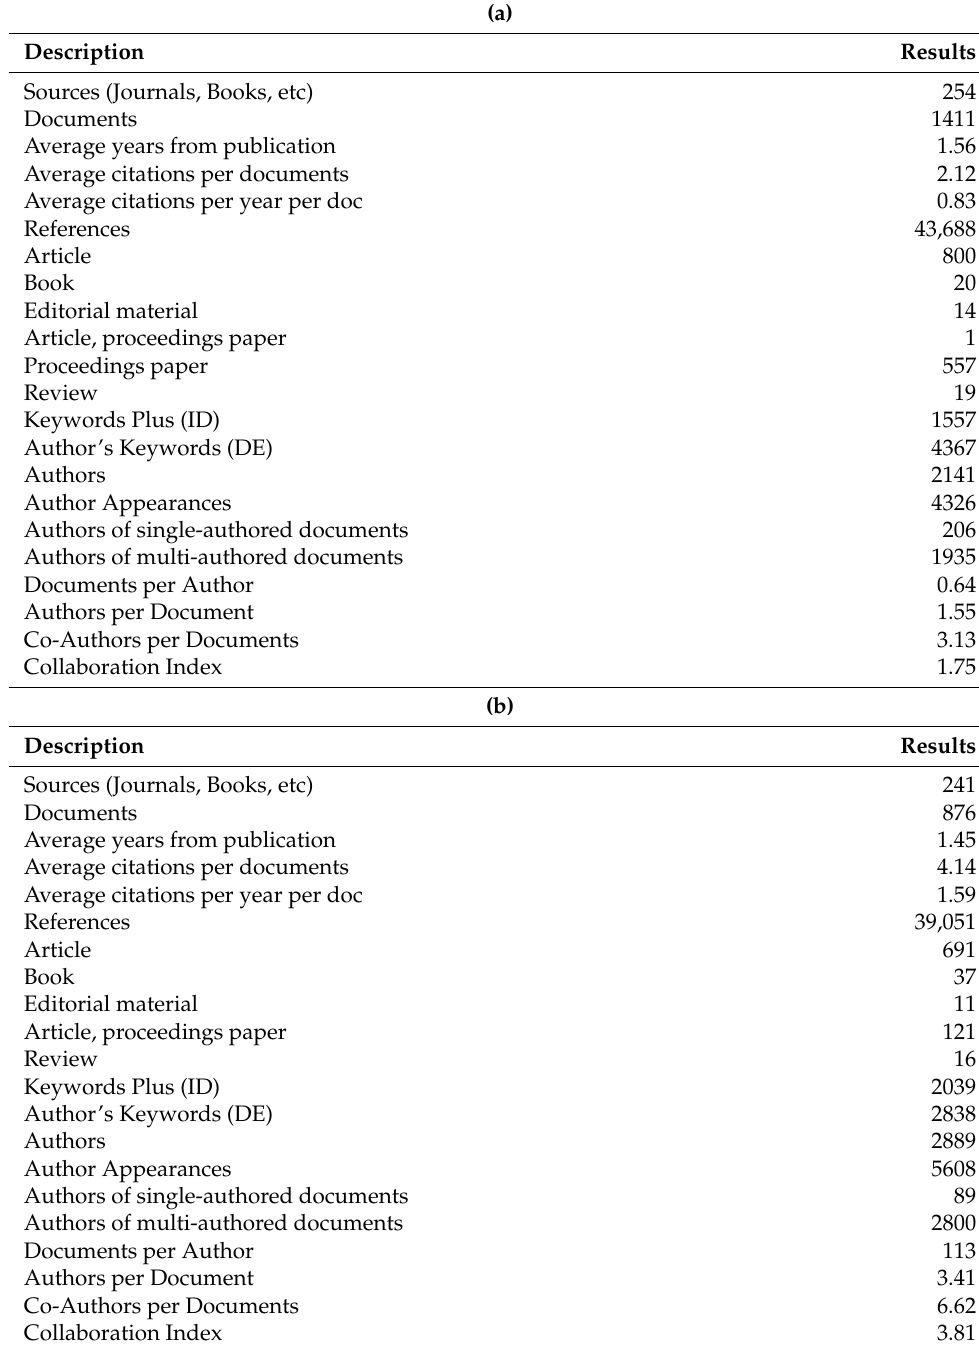
Table 2. Main information of the documents. ( a ) WoS. ( b )